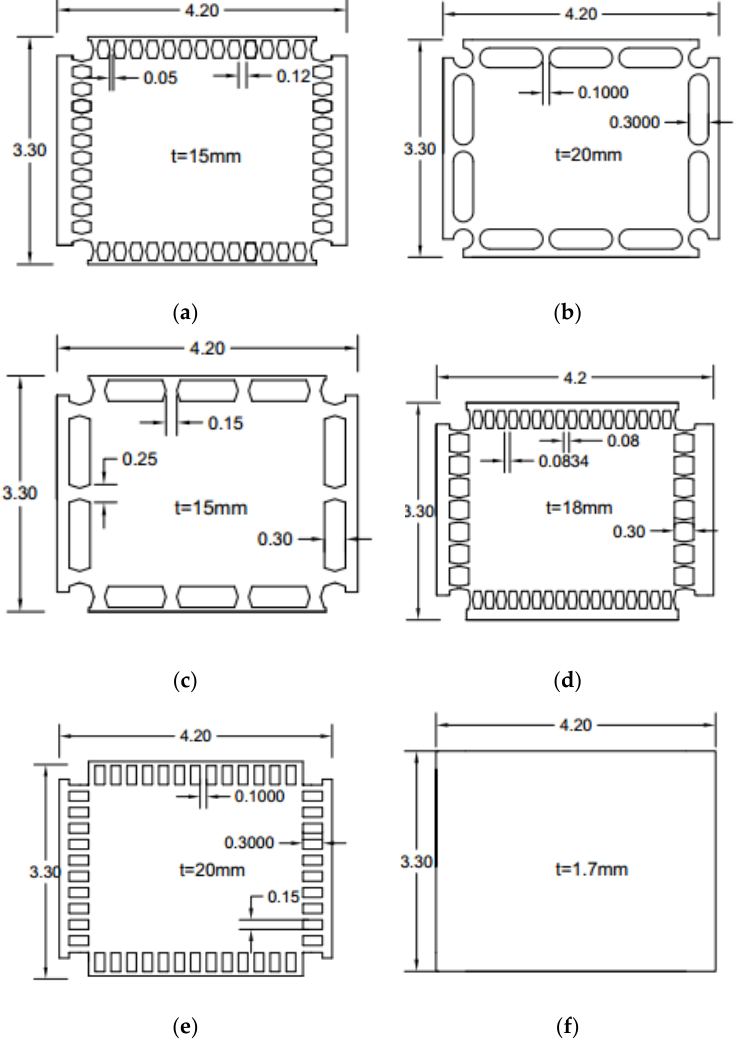
Figure 13. The conventional steel plate shear wall application ( a ) FBF ( b ) Circle ( c ) SBF ( d ) Oval ( e ) Straight ( f ) Solid.